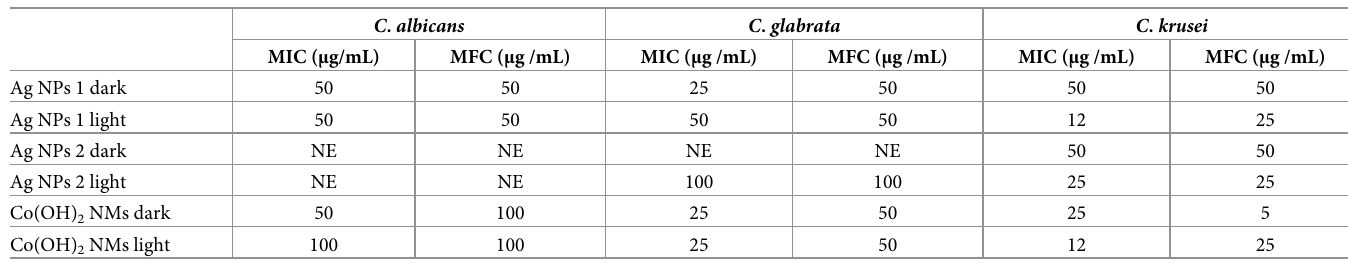
Table 4. MIC and MFC